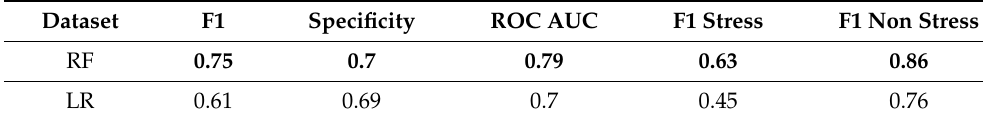
Table 5. Classification scores from UWS dataset using RF and LR